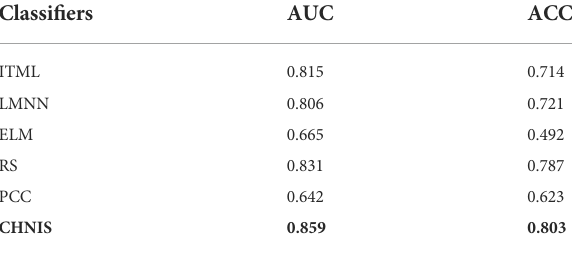
TABLE 3 Comparison of stability evaluation.